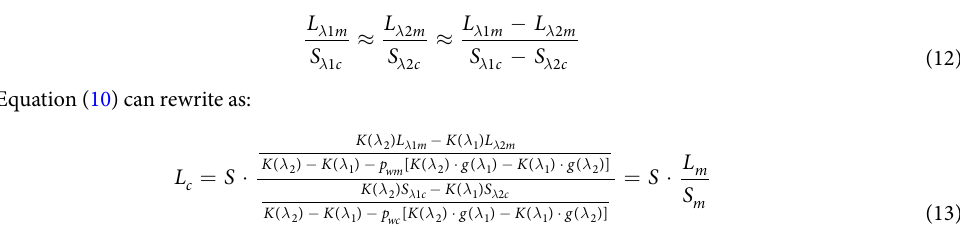
Set S be the overall length of the moving stage. The correction mirror is fixed at the terminal position of the stage, which is at the start of the reference mirror. This is beneficial because as the stage moves away from the reference mirror and L c increases, the effect of the humidity becomes more significant. However, as the path of the meas- urement arm gets closer to the correction arm, the effect of the humidity on the correction arm can help correct the effect of the humidity on the measurement arm.